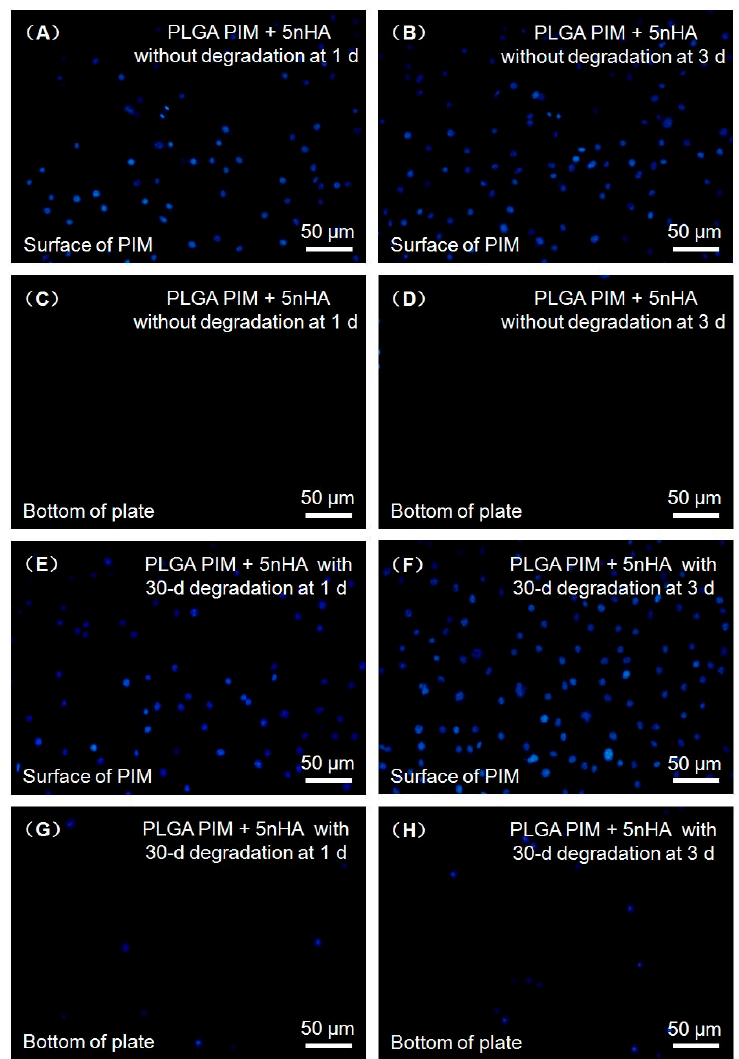
Figure 2. Representative fluorescent images of L929 cells cultured on the surface of PLGA PIM + 5 nHA: without ( A – D ) and with ( E – H ) degradation for one day ( A , C , E , G ) and three days ( B , D , F , H ). No cells were observed on the bottom of plate at one day and three days for PLGA PIM + 5 nHA without degradation. Few cells were observed on the bottom of plate at one day and three days for PLGA PIM + 5 nHA with 30-day in vitro degradation, which demonstrating PLGA PIM + 5 nHA exhibited an excellent cell barrier function. PIM, phase inversion membrane.